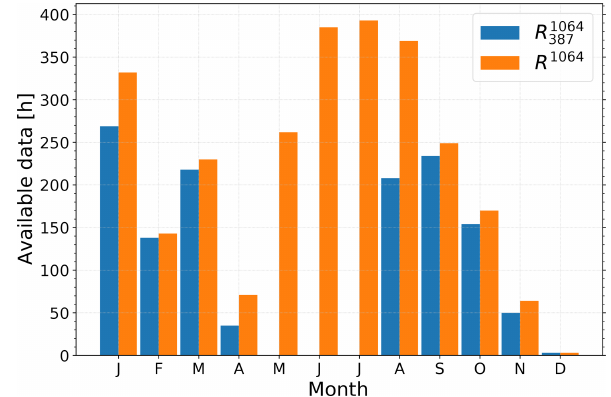
Figure 8. Available data in hours for each month for the years 2014 to 2017 for R 1064 (blue) and R 1064 387